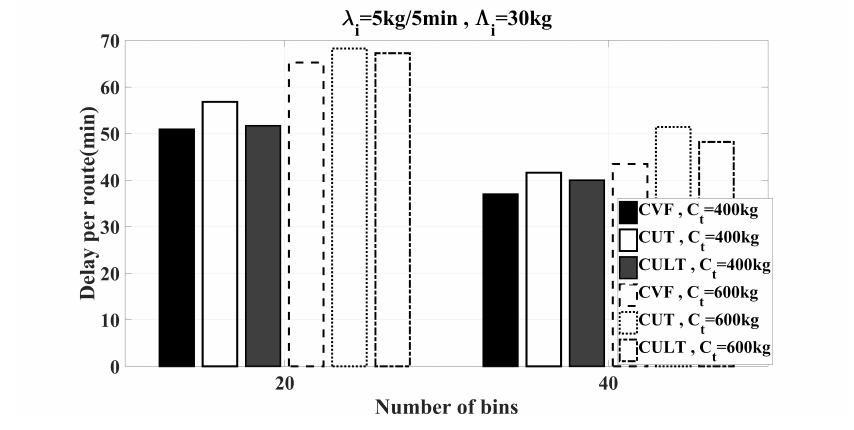
Figure 14. Delay per route: bin count when the bin capacity was increased.